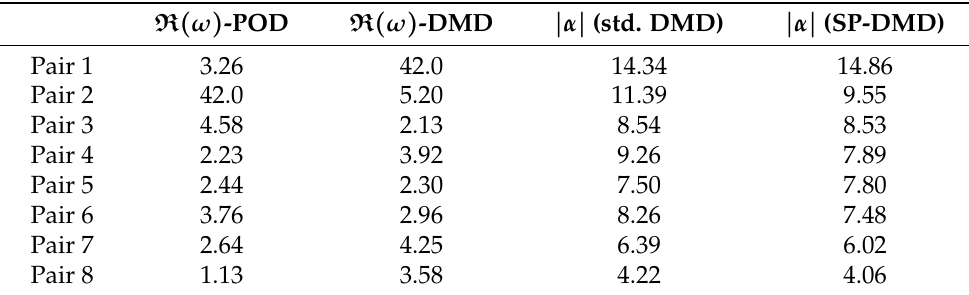
Figure 6. Fourier transform of the time coefficients a k ( t ) associated with the most energetic POD modes shown in Figure 4. Table 1. Frequencies and amplitudes of the selected complex conjugate dynamic modes’ pairs, computed with the standard and sparsity-promoting